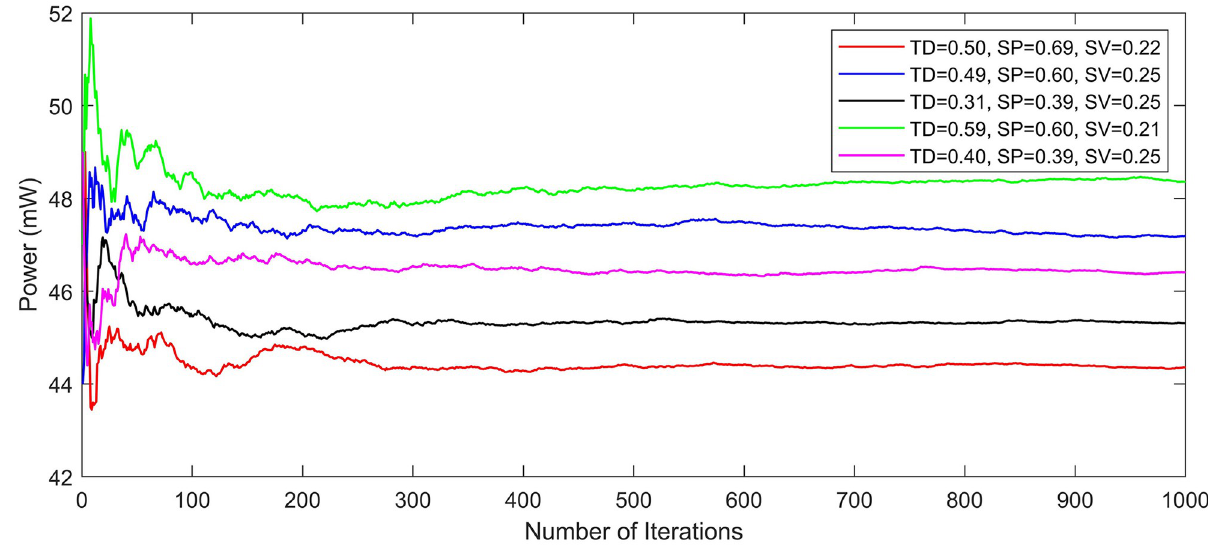
Fig 8. Convergence analysis of IP-2 (core-1) using Monte-Carlo simulation.